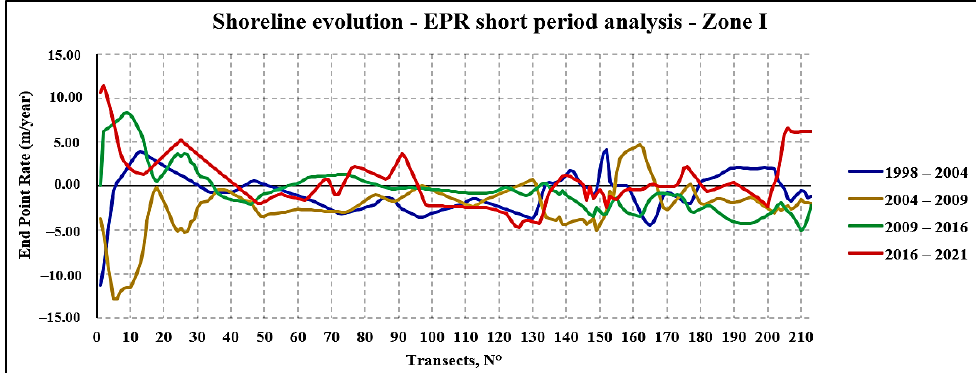
Figure 11. Accretion and erosion profiles obtained in zone I by applying the End Point Rate (EPR).